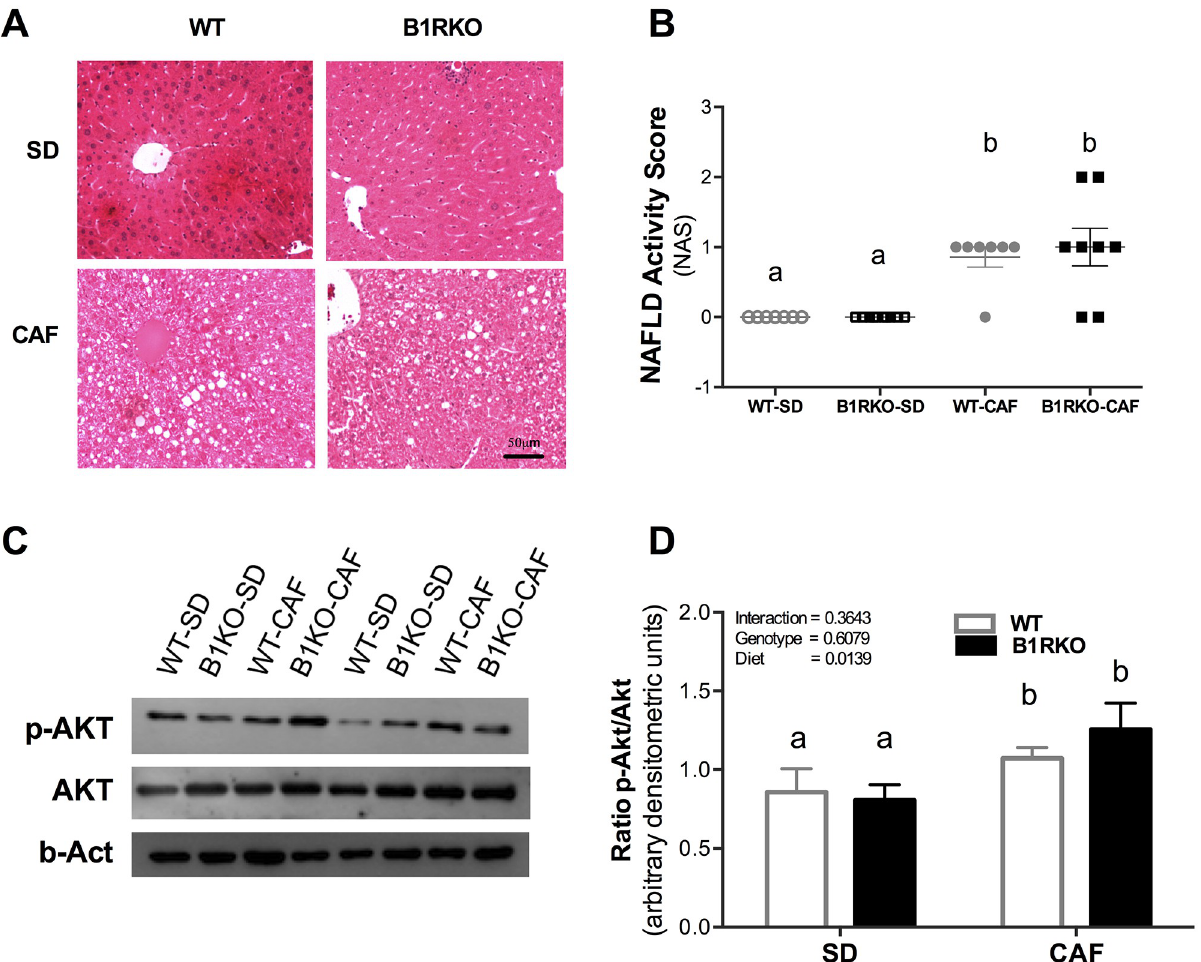
Fig 4. Liver fat infiltration and AKT phosphorylation according to the diet and genotype. A) Representative image comparing hematoxylin and eosin-stained liver sections of B1RKO and WT mice feed a CAF or standard (SD) diet (100x). B) NAFLD score. C) Representative image of p-AKT/ AKT on Western blot analysis and p-AKT/AKT ratio in the liver. D) Analysis of p-AKT/AKT ratio in the liver. P-value tested by two-way ANOVA followed by the Bonferroni post-hoc test. Different letters indicate differences in the post-hoc test. WT, wild-type; B1RKO, B1R knockout mice; SD, standard diet; CAF, cafeteria diet, WT-SD (n = 7), B1RKO-SD (n = 8), WT-CAF (n = 7), and B1RKO-CAF (n =